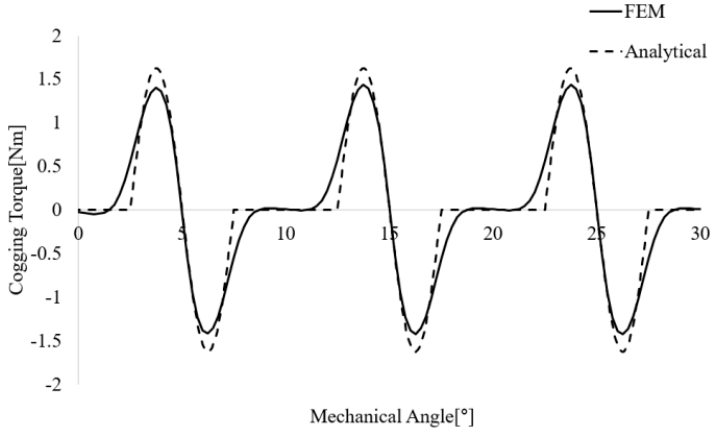
Figure 10. Comparison of the no-load-induced voltage derived from the HMEC and the FEM.